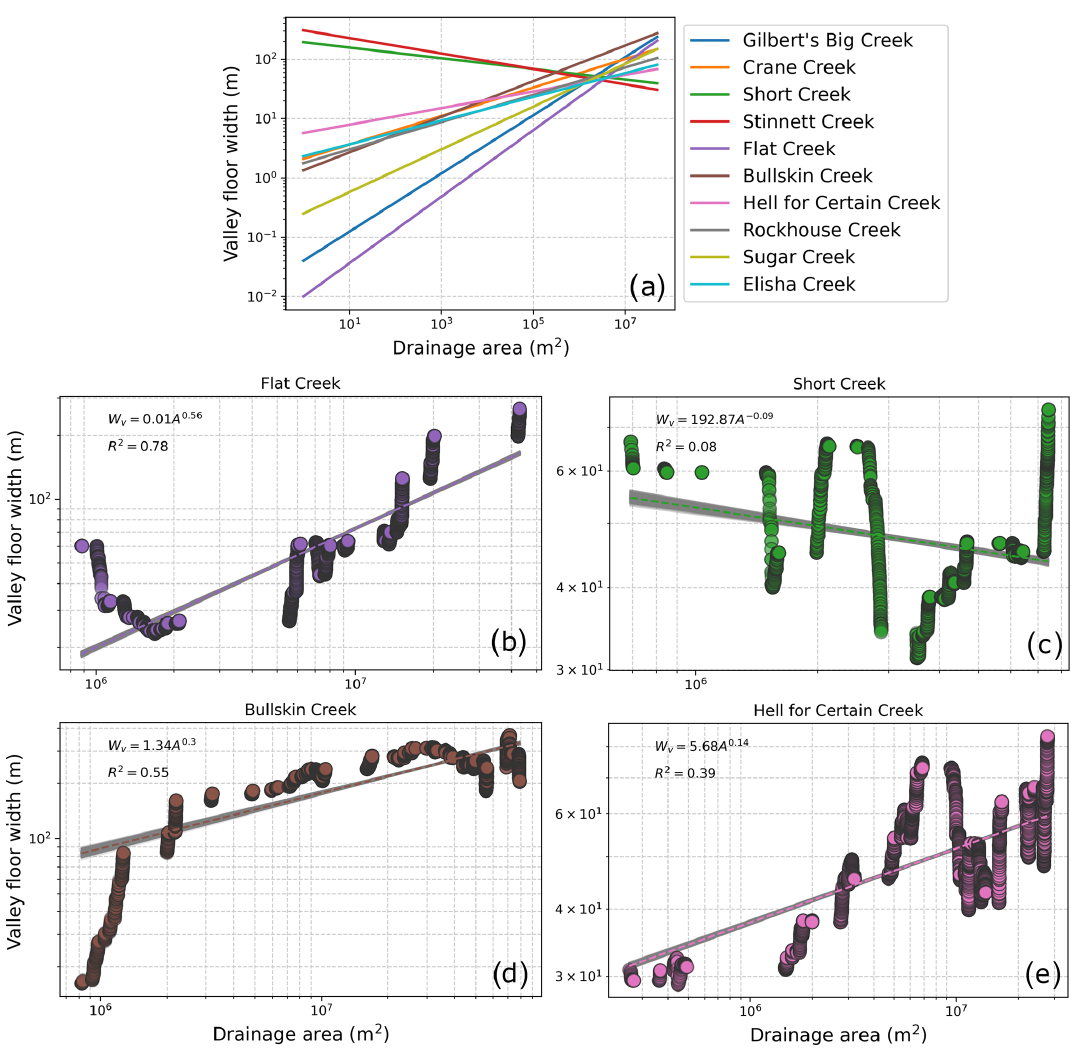
Figure 12. Width–area analysis for rivers in the Cumberland Plateau, Kentucky, USA. (a) Fitted power-law relationships for each of the rivers, showing eight of the rivers demonstrated a positive W v −− A relationship, while two of the rivers showed a negative relationship between W v and A . Example width–area plots for (b) Flat Creek; (c) Short Creek; (d) Bullskin Creek; and (e) Hell for Certain Creek showing variability between basins. The grey bars represent confidence intervals on the regressions, calculated by bootstrapping the data 1000 times with a 50% sample